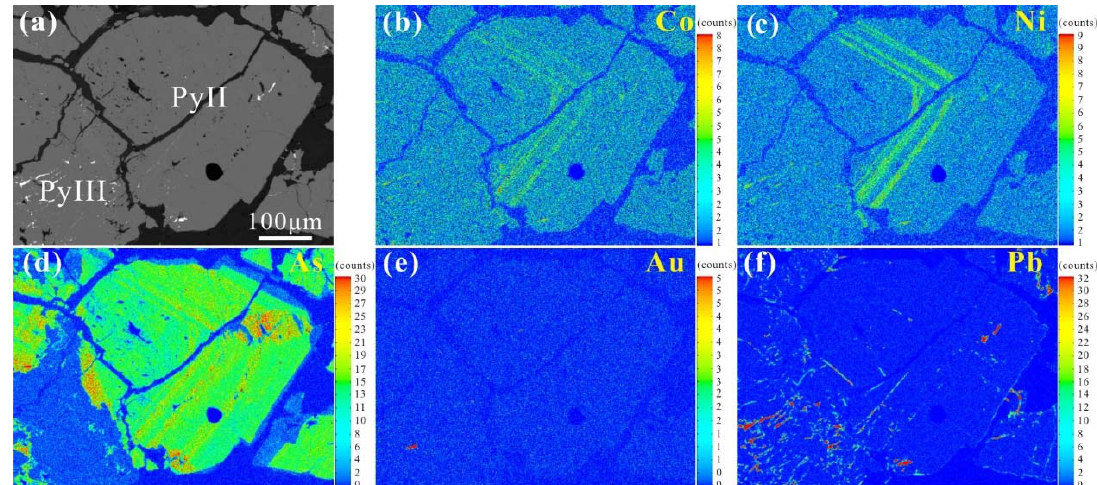
Figure 9. ( a ) Backscattered electron image of PyII and PyIII from sample 290-7. ( b – f ) X-ray element distribution maps of Co, Ni, As, Au, and Pb in PyII and PyIII. PyIII replace cataclastic PyII, as shown in Figure 6d.